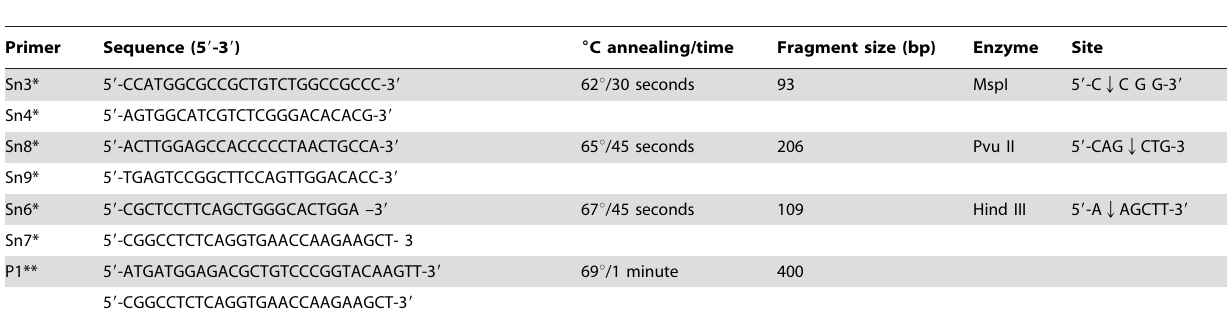
(i) Positive Lewis - included 92 individuals with the positive Lewis blood group phenotype, who were secretors of ABH, Le a and Le b antigens; (ii) Genuine Lewis-negative (phenotypically Le(a 2 b 2 ) in blood and saliva) –10 individuals with the genuine Le(a 2 b 2 ) blood phenotype, which all presented the le 59/508 and/or le 59/1067 haplotypes in the homozygous condition. Among these individuals 2 were ABH and Lewis non-secretors and 8 were only ABH secretors. (iii) Non-genuine Lewis-negative (characterized by Le(a 2 b 2 ) in blood but with expression of the Le a and/or Le b antigens in saliva) – included 48 individuals that had the 59T . G SNP in homozygote (n =14) or heterozygote (n= 14). In some cases (n= 20), this SNP was combined with the 508G . A and/or 1067T . A null alleles in the heterozygous condition. In this group, 10 individuals secreted only the Le a substance